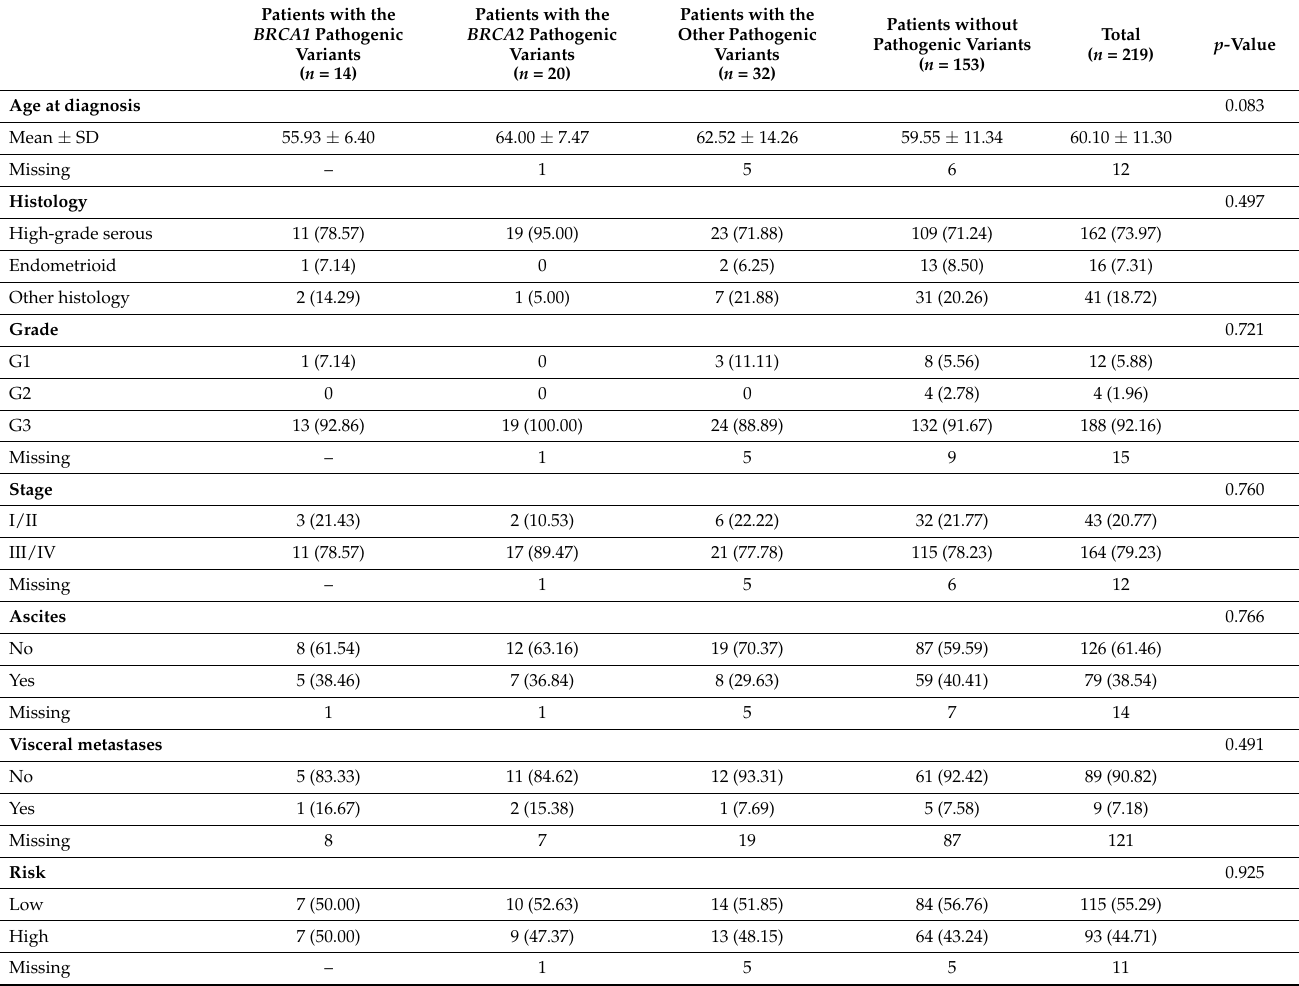
Table 1. Patient characteristics according to the mutational